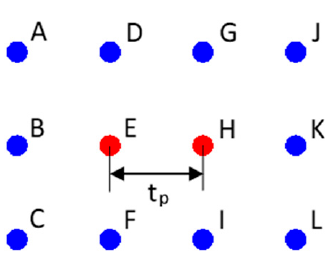
Figure 3. Temporal frequency of the LiDAR data.